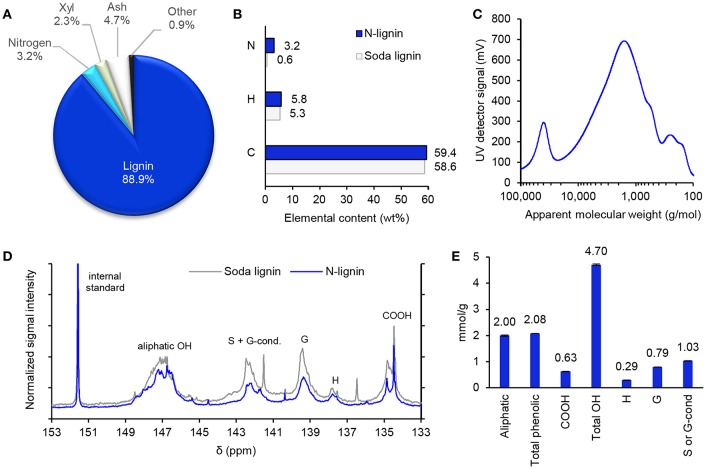
(A) Composition of N-lignin. (B) Carbon, hydrogen, and nitrogen contents of N-lignin compared to the published values of wheat straw soda lignin extracted from HT-straw (Sipponen, 2015). (C) HPSEC trace of N-lignin. (D)
31P NMR spectra of soda lignin (Sipponen, 2015) and N-lignin. (E) Quantities of aliphatic and phenolic hydroxyl groups and carboxylic acid groups of N-lignin based on 31P NMR analysis. Error bars indicate ± one standard deviation relative to the mean value.